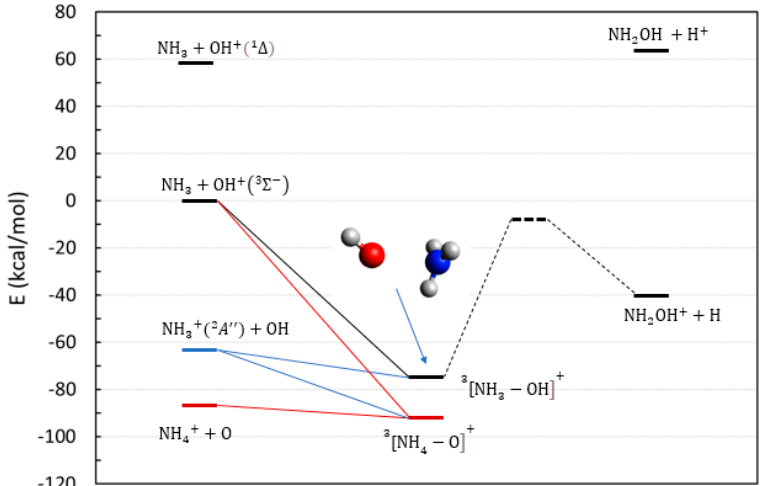
Figure 2. Energetic scheme of the possible entrance and exit channel of reactions 3 and 4 involving the system [ NH 3 − OH ] + with triplet multiplicity. The relative energies of the reactants of reactions 1 – 2 in their singlet state (top left) are also shown for comparison. Energies computed at CCSD(T)/Def2-TZVPP level.